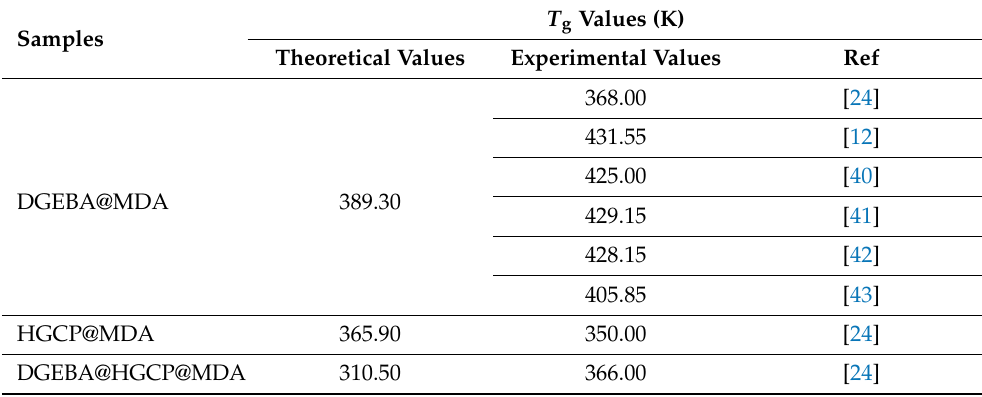
Table 3. Theoretical and experimental T g values for the DGEBA@HGCP@MDA, HGCP@MDA,